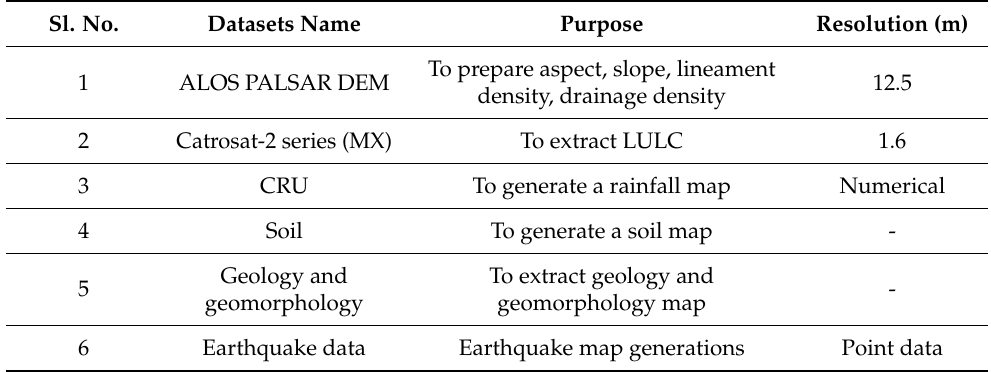
Table 1. Data used for generating landslide conditioning factor. Sl.